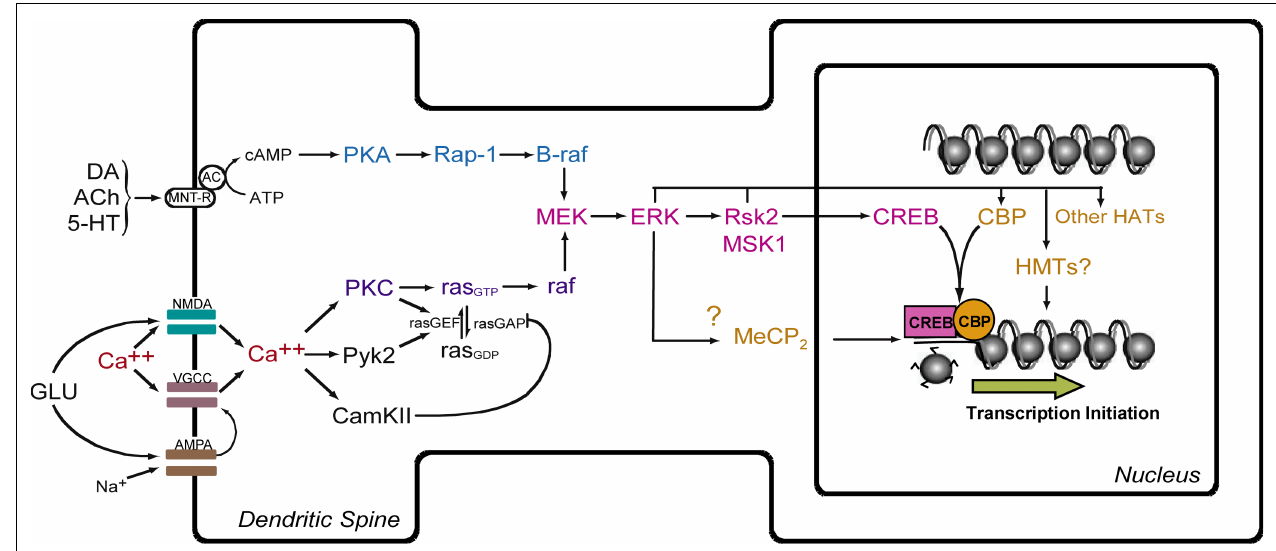
FIGURE 2 | Model for ERK-mediated regulation of histone modifi cation and gene transcription. Activation of NMDA receptors and voltage-gated Ca ++ channels (VGCC) leads to infl ux of Ca ++ and activation of the ras-MEK- ERK signaling cascade. This leads to activation of CREB-mediated transcription via action of Rsk2 and MSK1. CREB is postulated to facilitate